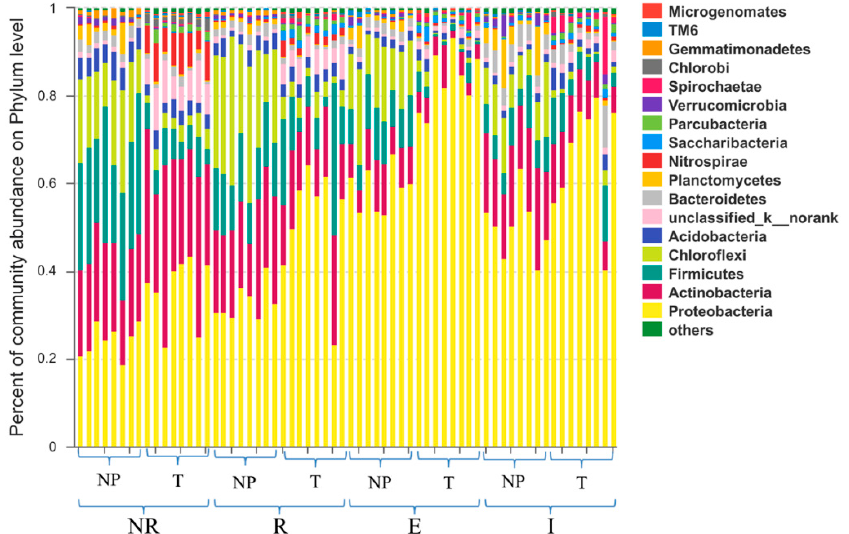
Figure 4. The distribution of the dominant bacteria at the phylum level in the non-rhizosphere (NR), rhizosphere (R), external layer of iron plaque (E) and internal layer of iron plaque (I) in the non-polluted soil (NP) and tailing soil (T).